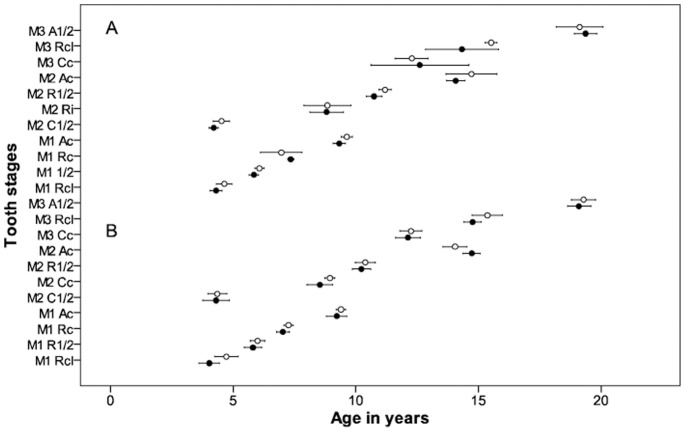
Mean ages of children entering tooth stages in malnourished and normal groups.Similarity of 95% confidence intervals of mean age entering selected tooth stages of molar teeth in malnourished and normal groups for body mass index (BMI) Z score shown in A and height for age (HA) Z score in B. This can be observed at each tooth stage. Open circles represent BMIZ and HAZ≤−2, dots represent BMIZ and HAZ ≥0. M1, first molar, M2, second molar, M3, third molar, C½, crown half formed, Cc, crown complete, Ri, initial root formation, Rcl, root cleft formation, R½, root half formed, Rc, root length complete, A½, apex half formed.